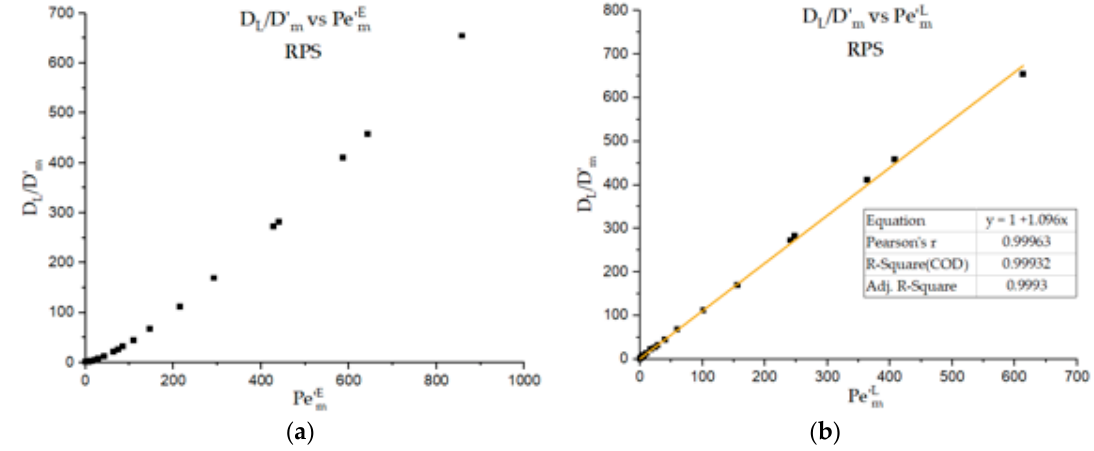
Figure 7. The ratio of the hydrodynamic dispersion coefficient over the effective molecular diffusion coefficient in an RPS-packed bed as a function of the Peclet number: ( a ) the dependence of that ratio on the Eulerian Peclet number calculated based on the diameter of the packed spheres and ( b ) the dependence of that ratio on the effective Peclet number determined from the Lagrangian length scale.